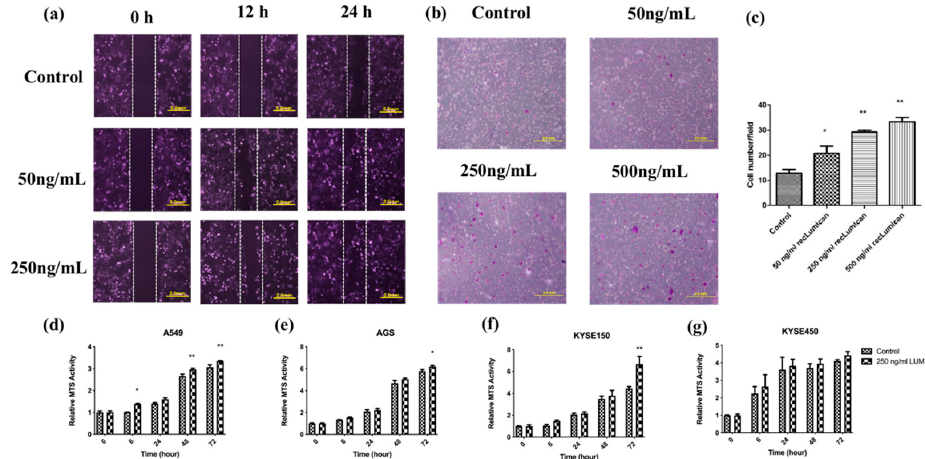
Figure 5. Lumican -induced cancer cell migration, invasion, and proliferation. ( a ) Images of wound- healing assay with recLumican protein treatment (50 ng/mL or 250 ng/mL) on KYSE150 cells at 0 h, 12 h, and 24 h. Exposure time: 12.5 ms. Original magnification: 10×. Scale: 2 mm. ( b ) Cell invasion assay with the transwell matrigel chamber and KYSE150 cells cocultured with different concentra- tions of purified human recLumican. Original magnification: 40×. ( c ) Average invaded cell numbers of KYSE150 cocultured with different concentrations of purified human recLumican (0, 50, 250, 500 ng/mL recLumican). The invaded cells were counted under a microscope in four random fields at the original magnification of 40×. * p < 0.05; ** p < 0.01. Proliferation curves of cancer cells cocultured with or without 250 ng/mL human recLumican of ( d ) A549 cells; ( e ) AGS cells; ( f ) KYSE150 cells; (g) KYSE450 cells. N = 3. Fresh culture medium was applied as the blank control. * p < 0.05; ** p < 0.01.